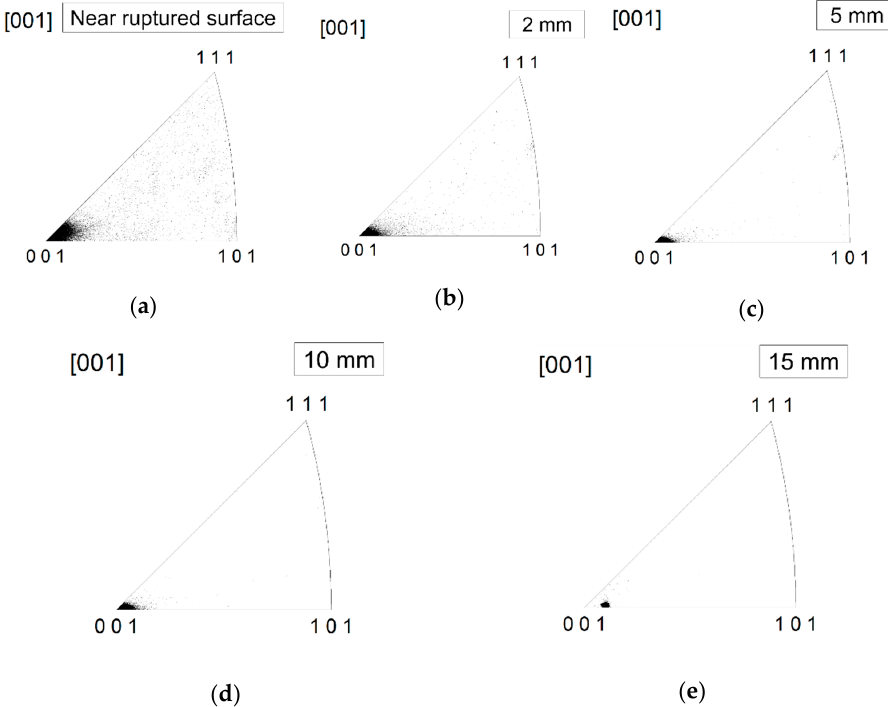
Figure 10. Standard stereographic triangles analyzed using electron backscatter diffraction (EBSD) in ruptured specimen parallel to applied stress axis as a function of distance from the ruptured surface. The creep test was conducted under the condition of 760 °C and 520 MPa. The analyzed area was rectangular with approximately 1000 μ m in the applied stress axis and approximately 2000 μ m in the direction perpendicular to applied stress axis. EBSD analysis was conducted at the step size of approximately 5 μ m. ( a ) Near the ruptured surface, ( b ) 2, ( c ) 5, ( d ) 10, ( e ) 15 mm away from the ruptured surface.